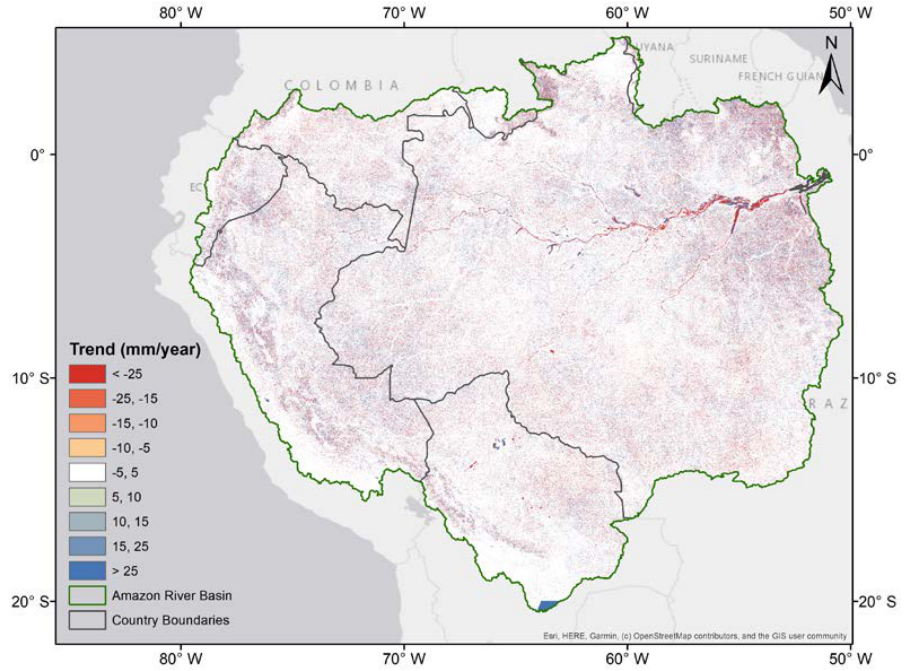
Water 2020 , 03 , x FOR PEER REVIEW Figure 12. Evapotranspiration trends from 2003 to 2013 in the Amazon Basin. Figure 12. Evapotranspiration trends from 2003 to 2013 in the Amazon Basin.